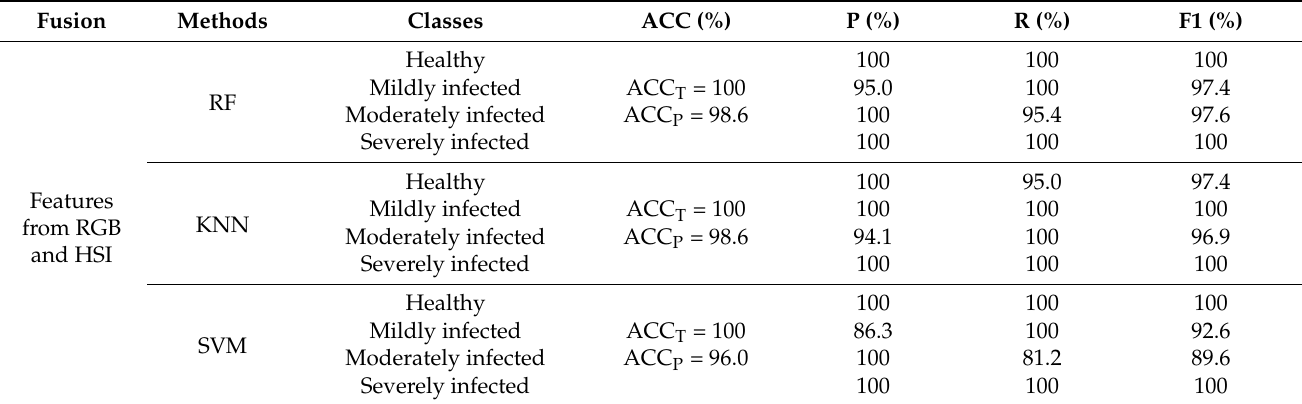
Table 3. Classification results of BRM infection degree in apples using RF, KNN, and SVM with fused